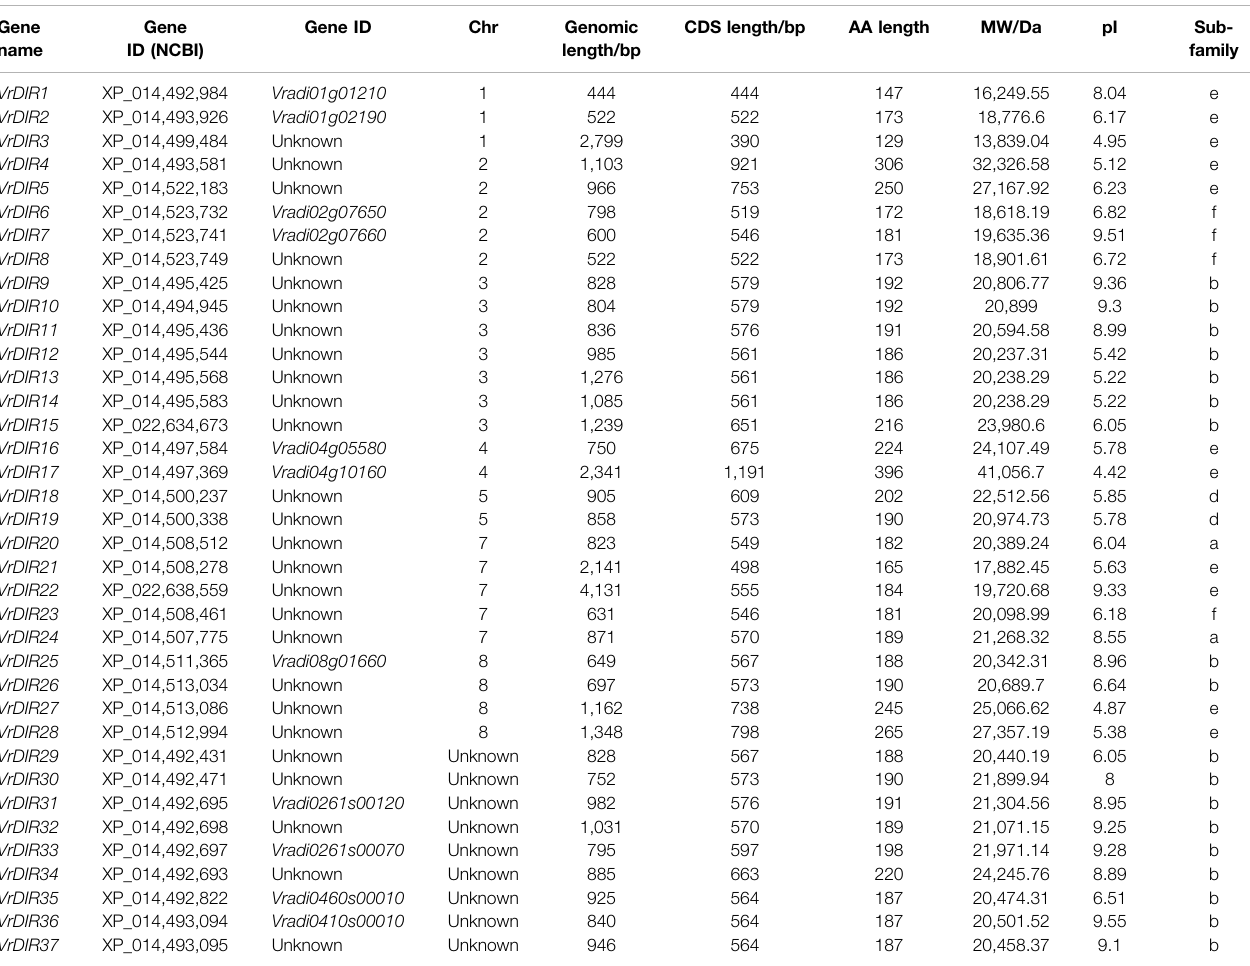
TABLE 1 | VrDIR genes identi fi ed in